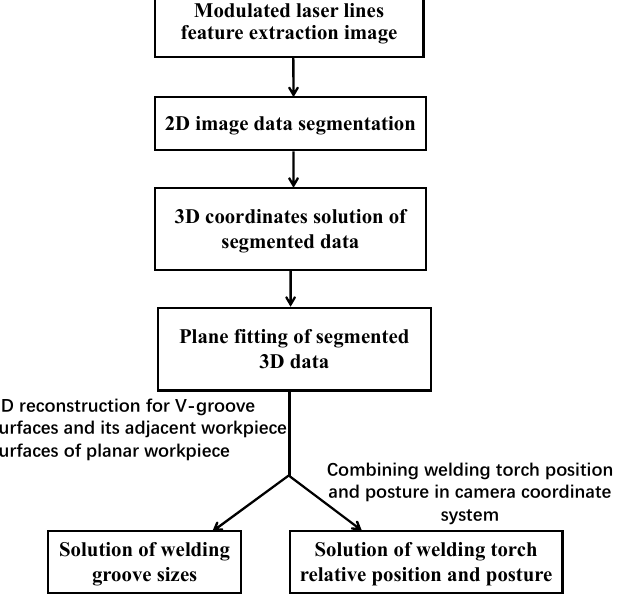
Figure 6. The solution flow of the welding groove sizes and welding torch relative position and posture parameters.